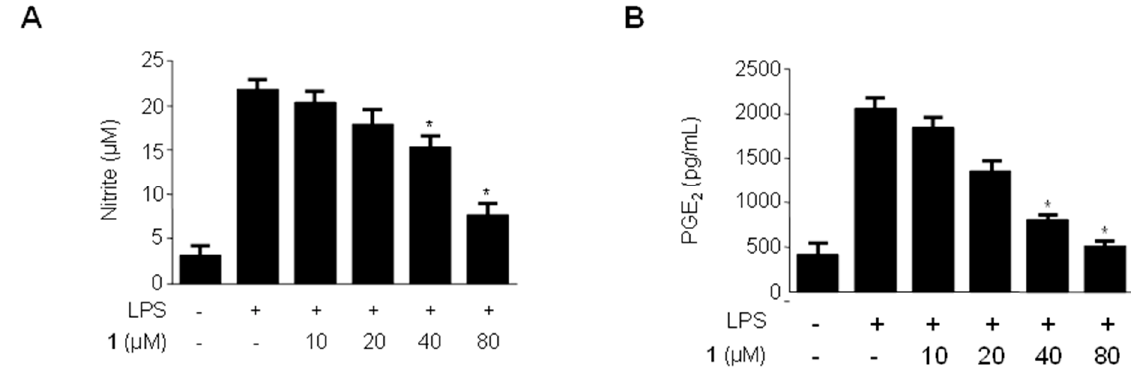
Figure 4. Effects of methylpenicinoline ( 1 ) on nitrite ( A ); PGE 2 ( B ); IL-1 β ( C ); and IL-6 ( D ) production in BV2 microglia stimulated with LPS. Cells were pre-treated for 30 min with the indicated concentrations of 1 , and then stimulated for 24 h with LPS (500